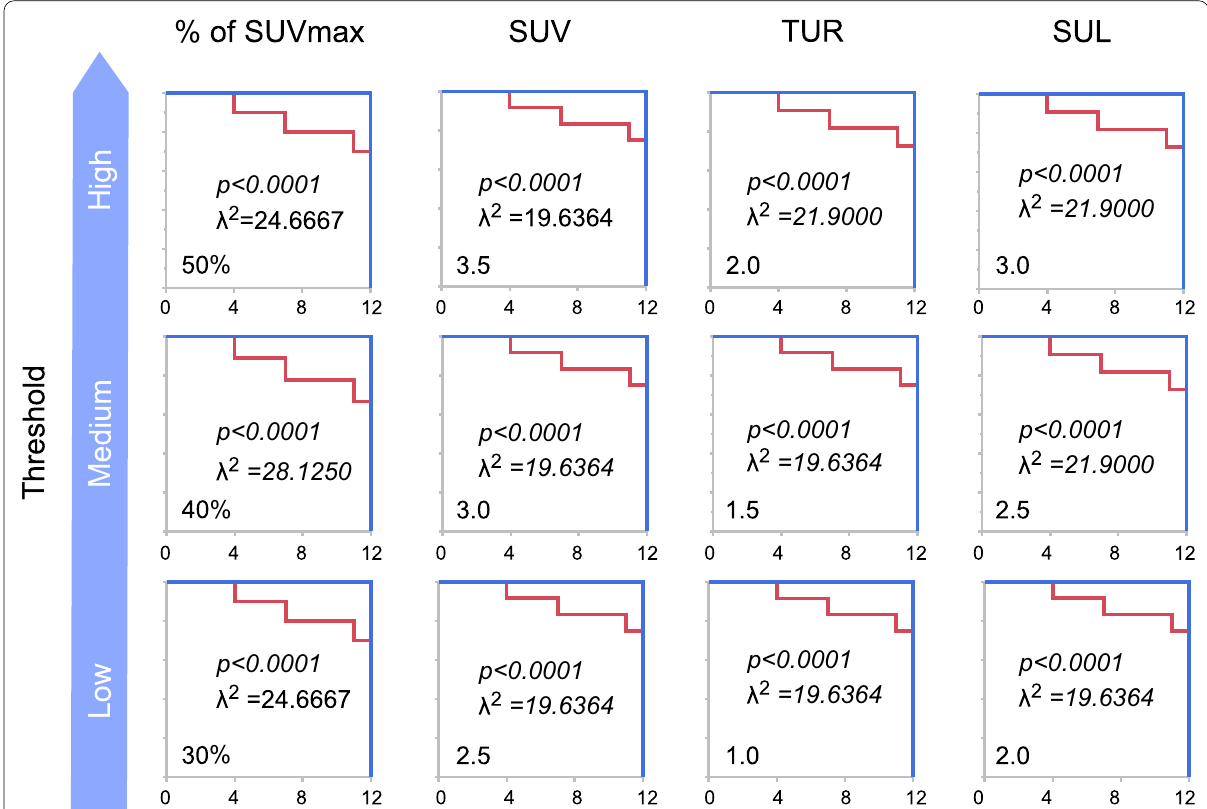
Fig. 4 Relapse-free survival curve showing TLG for each threshold. SUVmax, maximum standardized uptake value; MTV, metabolic tumor volume; TLG, total lesion glycolysis; TUR, tumor-to-liver uptake ratio; SUL, SUV normalized to lean body mass. Relapse-free survival curves of the patients were divided by values below and above the cut-off value obtained using ROC analysis. For all the parameters for TLG, particularly 40% of tumor SUVmax for TLG (TLG 40%), the values above the cut-off value were more frequently associated with recurrence than the values below the cut-off